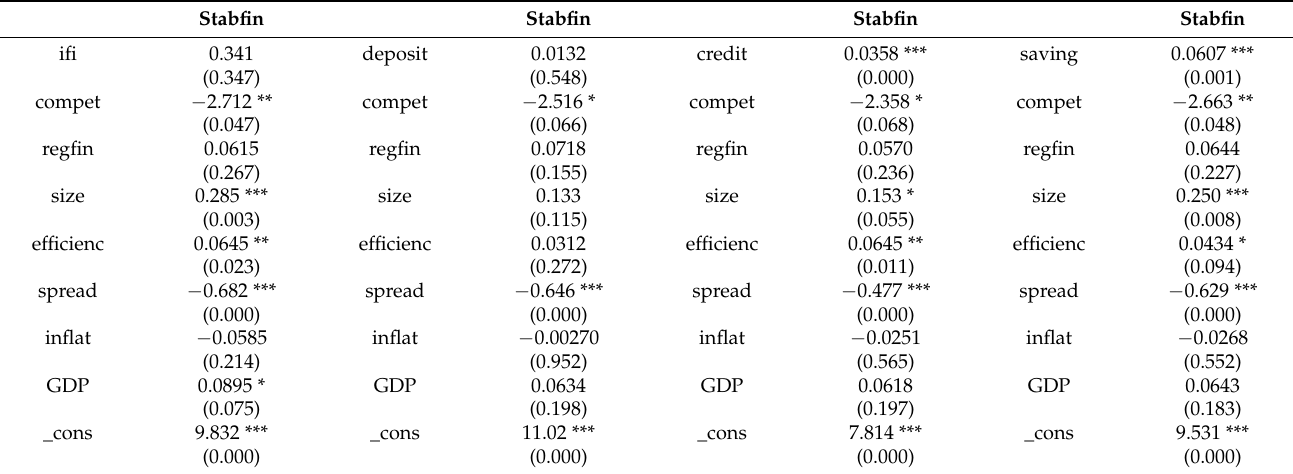
Table 8. Effect of financial inclusion on financial stability in SSA